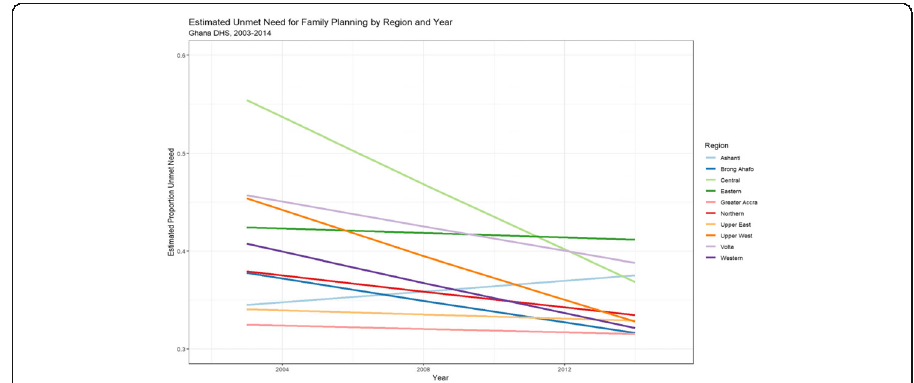
Fig. 2 Trends in the prevalence of unmet need for family planning in Ghana: 2003 –